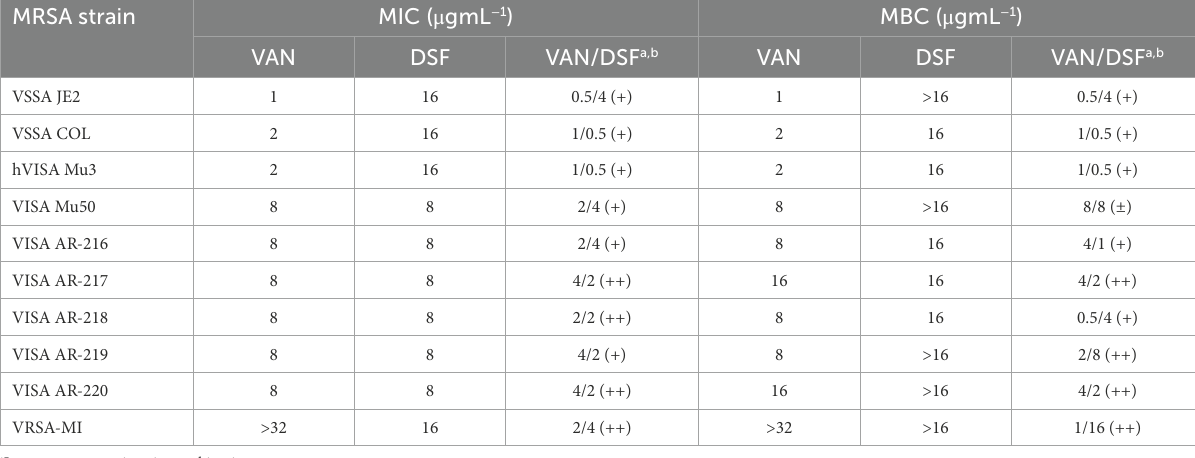
TABLE 1 Comparison of MIC and MBC values for VAN and/or DSF